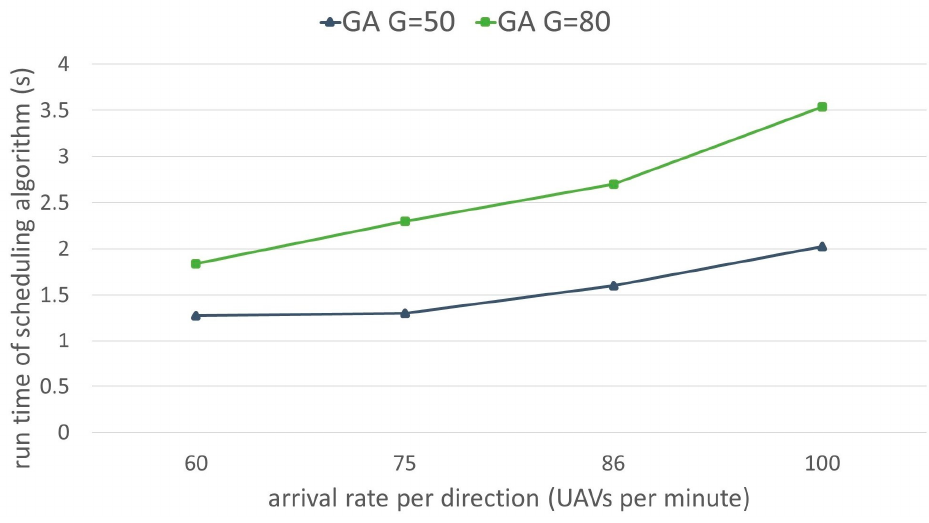
Figure 20. Average scheduling run time of UAVs every 𝑘∆𝑡 using mode 2.